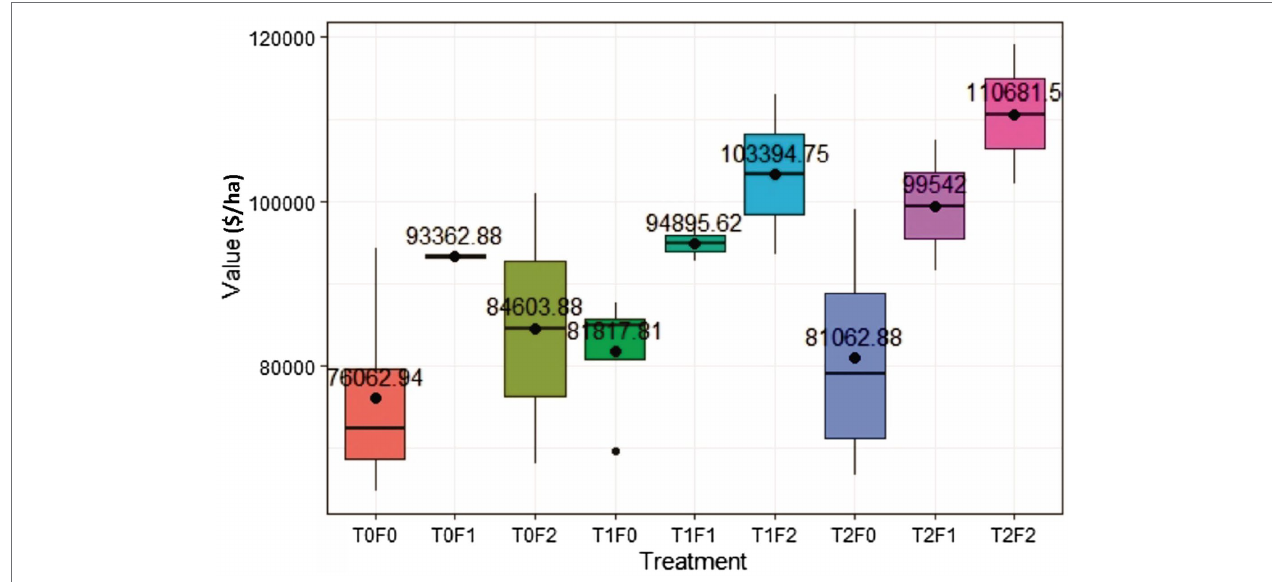
FIGURE 5 | Simulated lumber value recovery for Douglas-fir ( Pseudotsuga menziesii Mirbel) trees as a function of different combinations of pre-commercial thinning (PCT) and fertilization, 40 years after initial treatments at the Shawnigan Lake trial in British Columbia, Canada. T0, T1, and T2 correspond to 0, 1/3, and 2/3 basal area removal, respectively. F0, F1, and F2 correspond to 0, 224, and 448 kg N/ha fertilization with urea, respectively. TABLE 3 | Two-way ANOVA results for lumber value recovery of Douglas-fir ( Pseudotsuga menziesii Mirbel) trees under different treatments, 40 years after application at the Shawnigan Lake trial in British Columbia, Canada. Effects